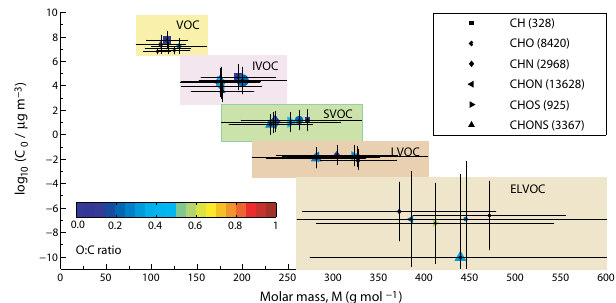
Figure 2. Average molar mass ( M) , saturation mass concentra- tion ( C 0 ) , and O : C ratio for organic compounds from the NCI database categorized by elemental composition (CH, CHO, CHN, CHON, CHOS, CHONS) and volatility (VOC, IVOC, SVOC, LVOC, ELVOC). The data points and error bars represent arith- metic mean values and standard deviations for each class of ele- mental composition. The symbol sizes are scaled by the number of compounds in each class. The center and borders of the colored boxes represent the mean and standard deviations of all compounds included in each volatility class.